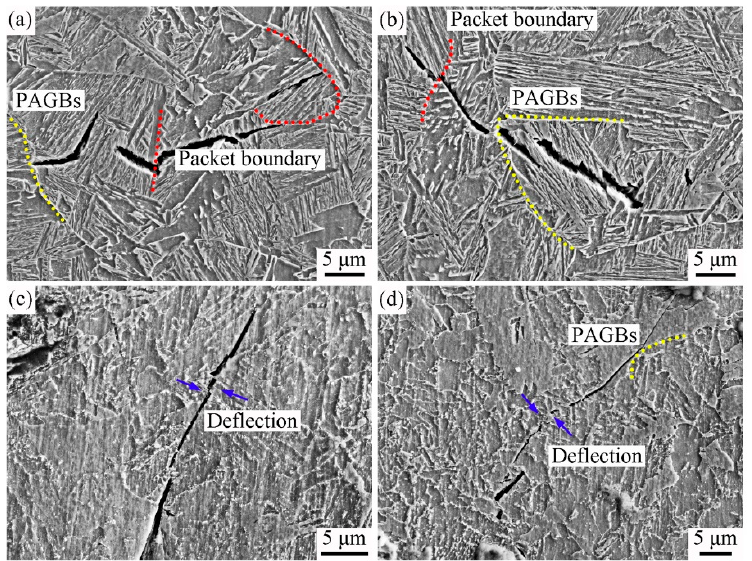
Figure 9. Surfaces perpendicular to the fracture of the specimens after water-quenching or temper- ing at 600 °C. ( a , b ) WQ, ( c , d )